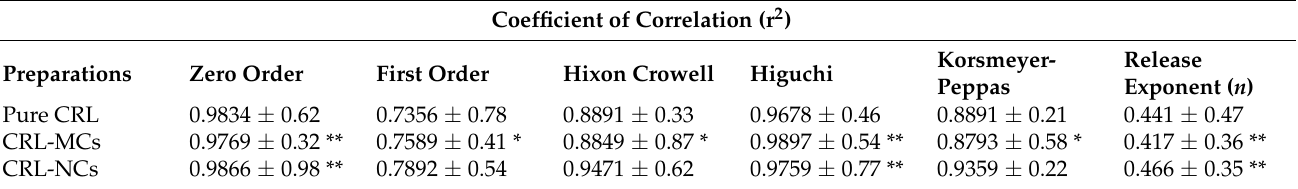
Table 3. In vitro release kinetics of pure CRL, CRL-MC, and -NCs (mean ± SD, n = 3). Coefficient of Correlation (r 2 )